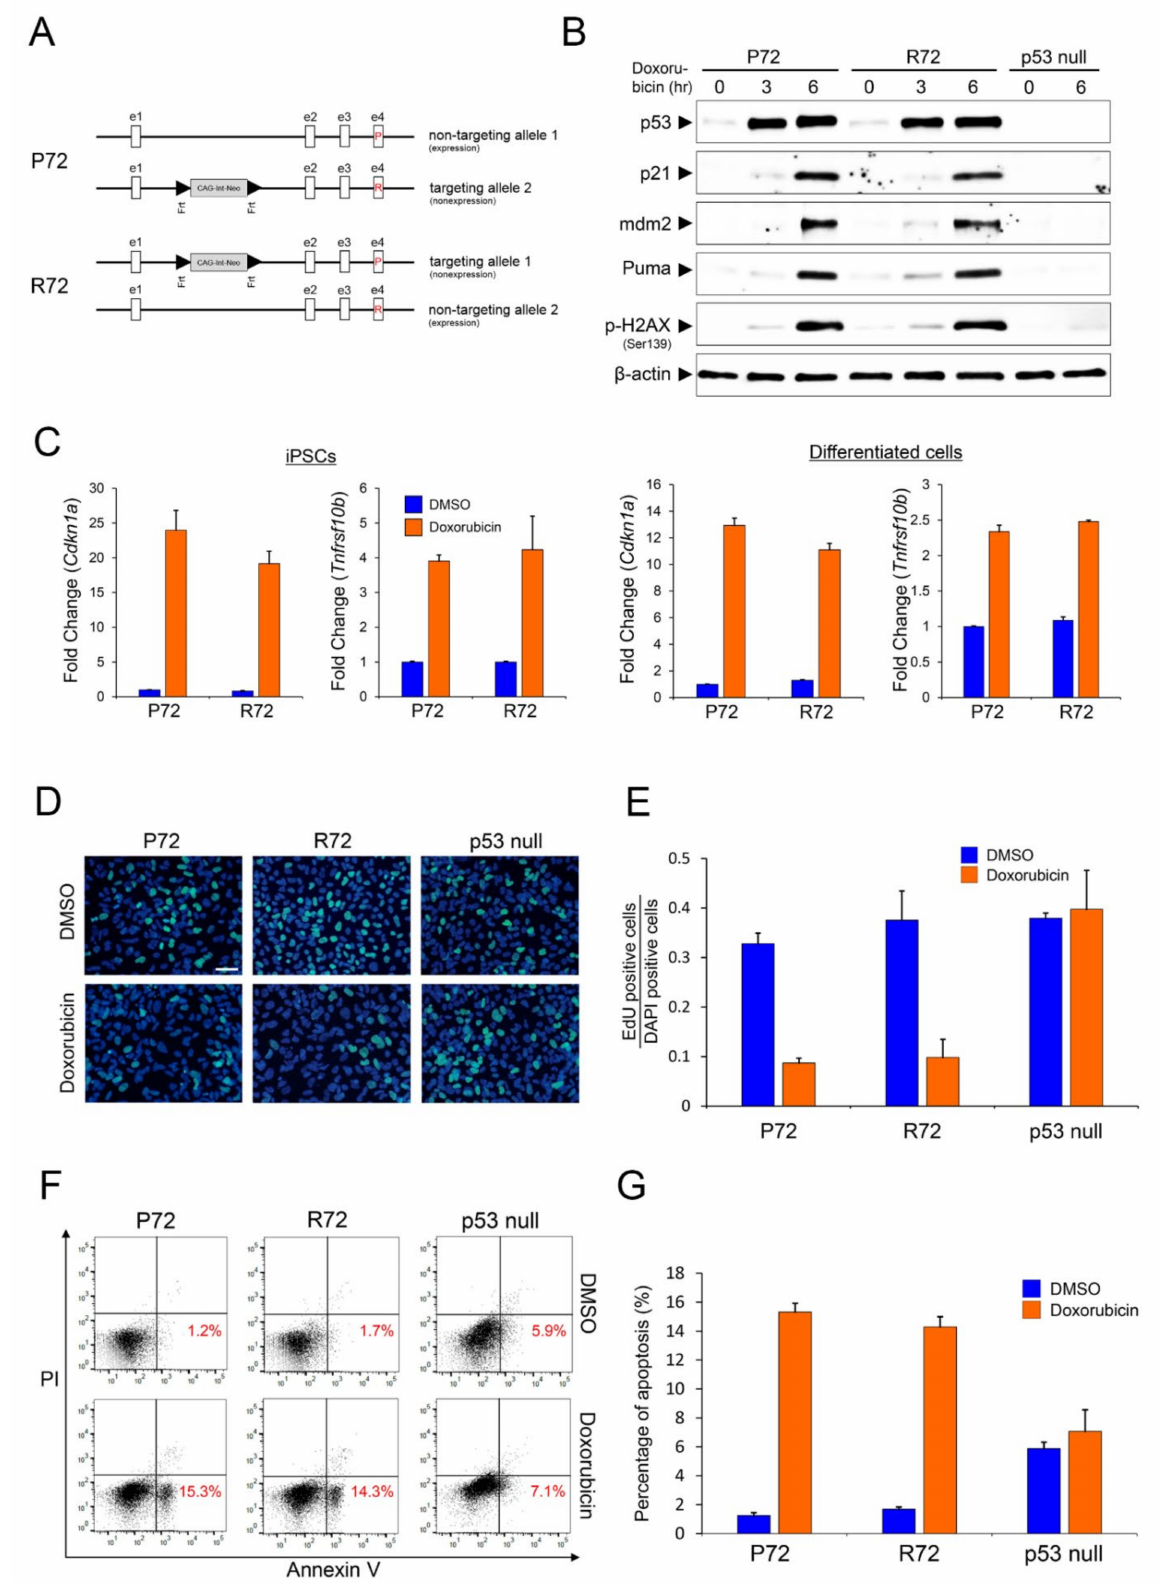
Figure 1. Similar functional patterns shown in P72 and R72 cells under DNA damage stress. ( A ) Targeting scheme for polymorphic p53 codon 72. The parent cells have an inherited heterogenous polymorphism at codon 72 at TP53 exon 4. Each allele was used in the construction of bacterial artificial chromosome (BAC)-based targeting vectors ( B ) Western blot